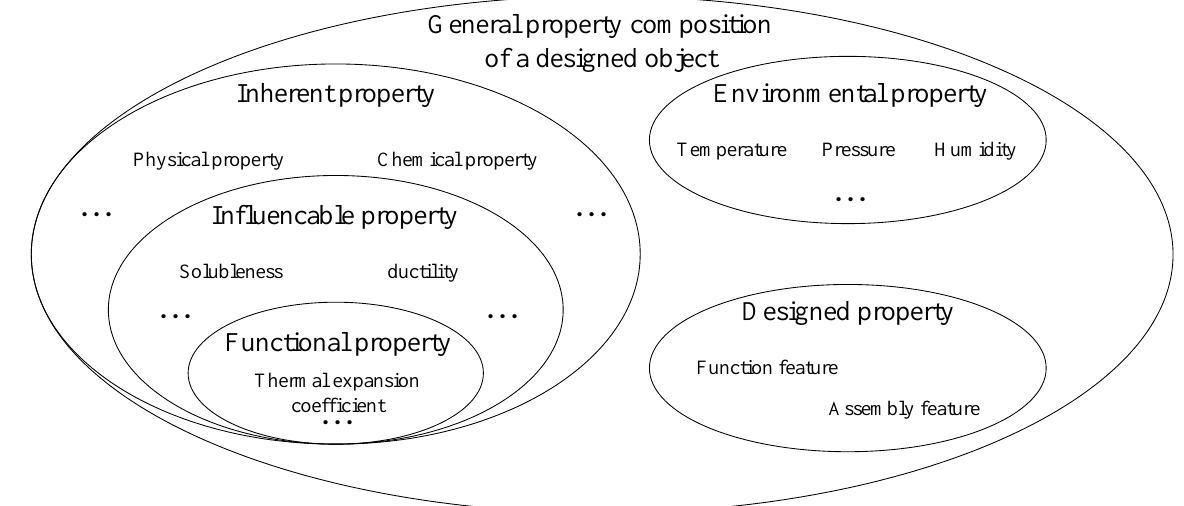
Figure 1. The general property composition of a design object.